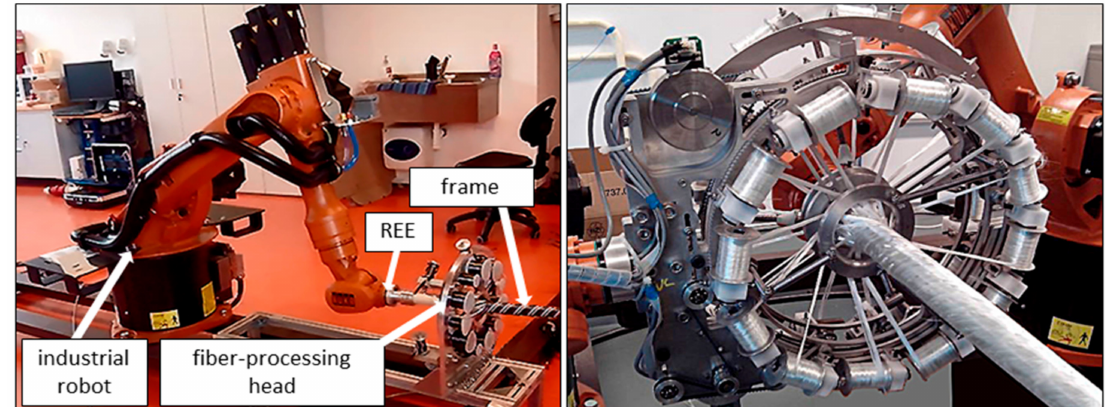
Figure 2. The process of winding of fibers on a frame; fiber-processing head only with one guide-line creates one layer of fibers on a frame (on the ( left )), detail of fiber-processing head with three guide-lines that creates gradually three layers of glass fibers on the frame (on the ( right